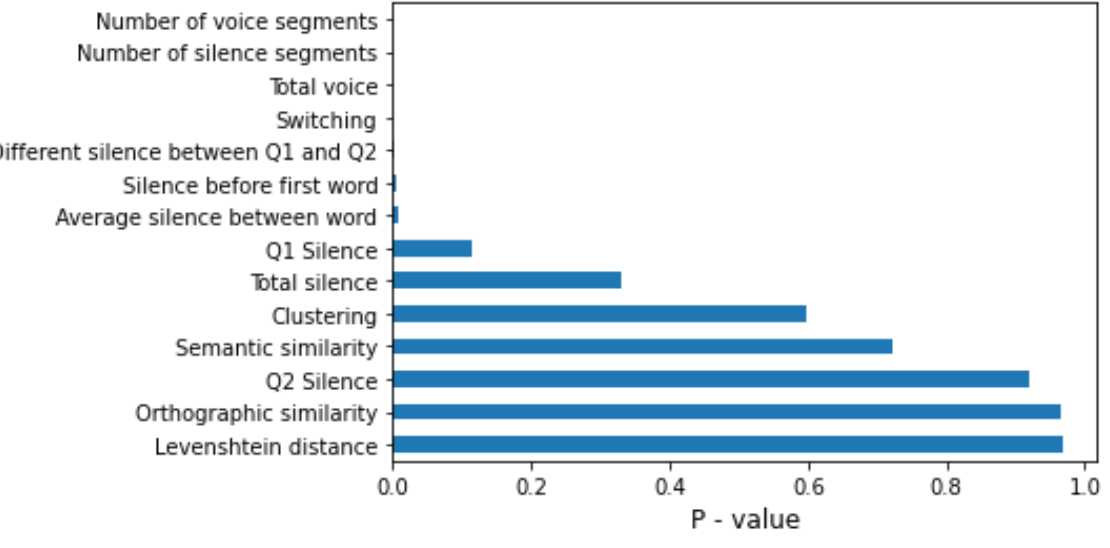
Figure 8. The p -values obtained from the chi-square test of the feature-selection process.